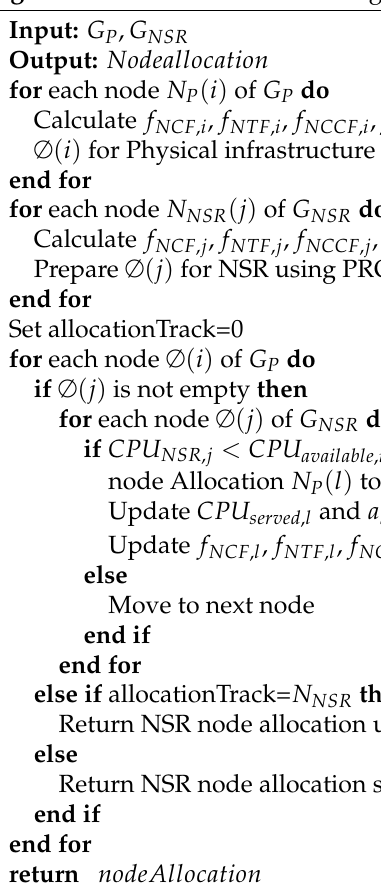
Algorithm 1 Node allocation through